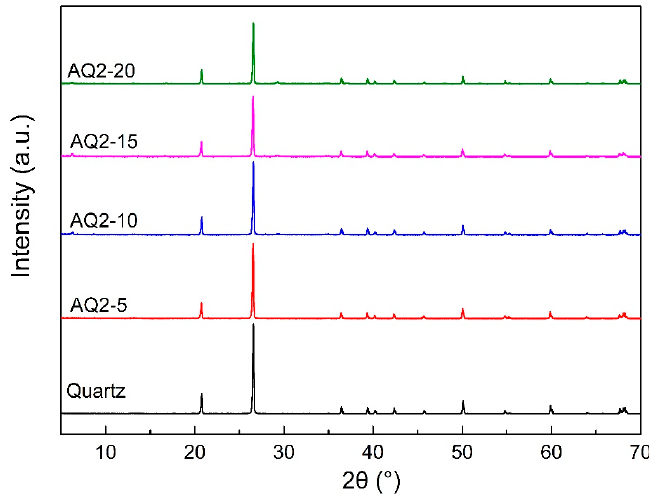
Figure 3. XRD patterns of quartz and quartz-2 activated with various contents of NaOH.